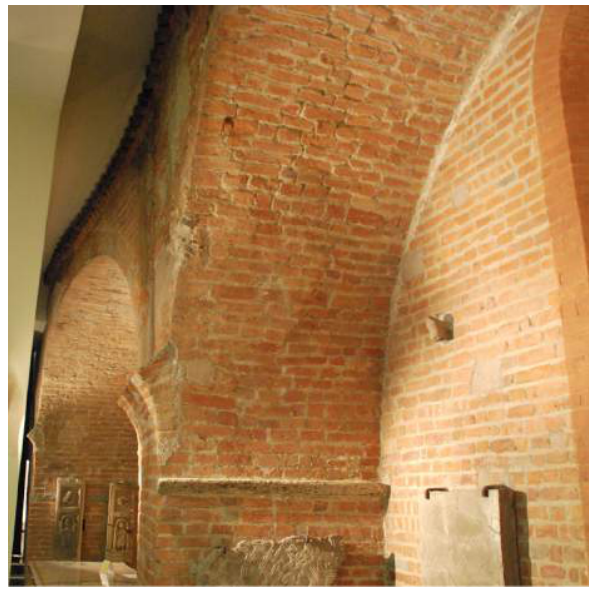
Figure 5. The double-curve